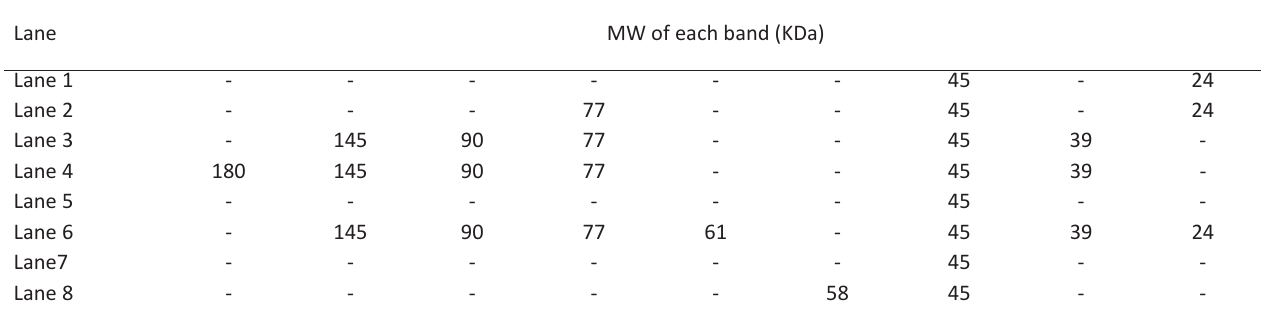
Table 5 ­ Quantity of the protein loaded on each lane detected with TCA/acetone method (samples 1­4) and with phenol extraction method (samples 5­8) in the SDS­PAGE system 12% from the Cereus plants Lane MW of each band